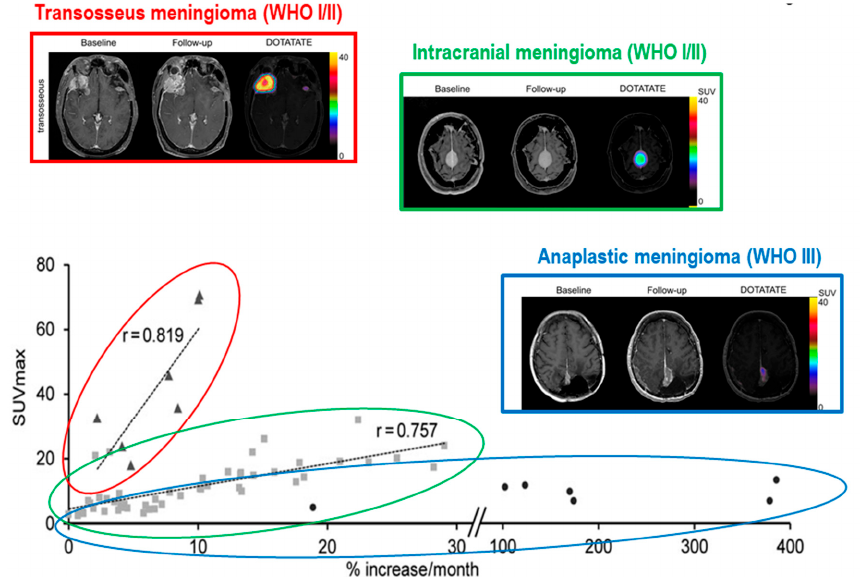
Figure 1. Correlation between SSTR-PET positivity and growth rate in meningioma. The tumour growth rate is directly correlated with SUVmax in grade I and II intracranial meningiomas (green), while this correlation is weak for grade III lesions (blue). As a consequence, high expression of SSTR2 seems to predict faster growth only in well-differentiated meningiomas. Moreover, meningiomas with transosseous growth (red) elicited considerably higher 68Ga-DOTATATE binding. Adapted with permission from Sommerauer et al. [59].